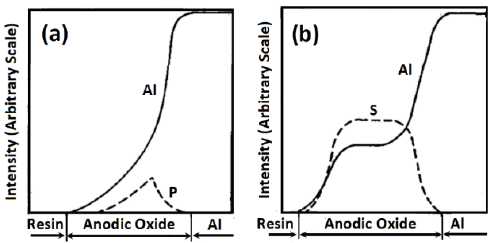
Figure 3. Phosphorus and sulfur profiles for anodic oxide films formed in ( a ) phosphoric acid bath, and ( b ) sulfuric acid bath. Reproduced with permission from The Electrochemical Society of Japan from Ref [102].